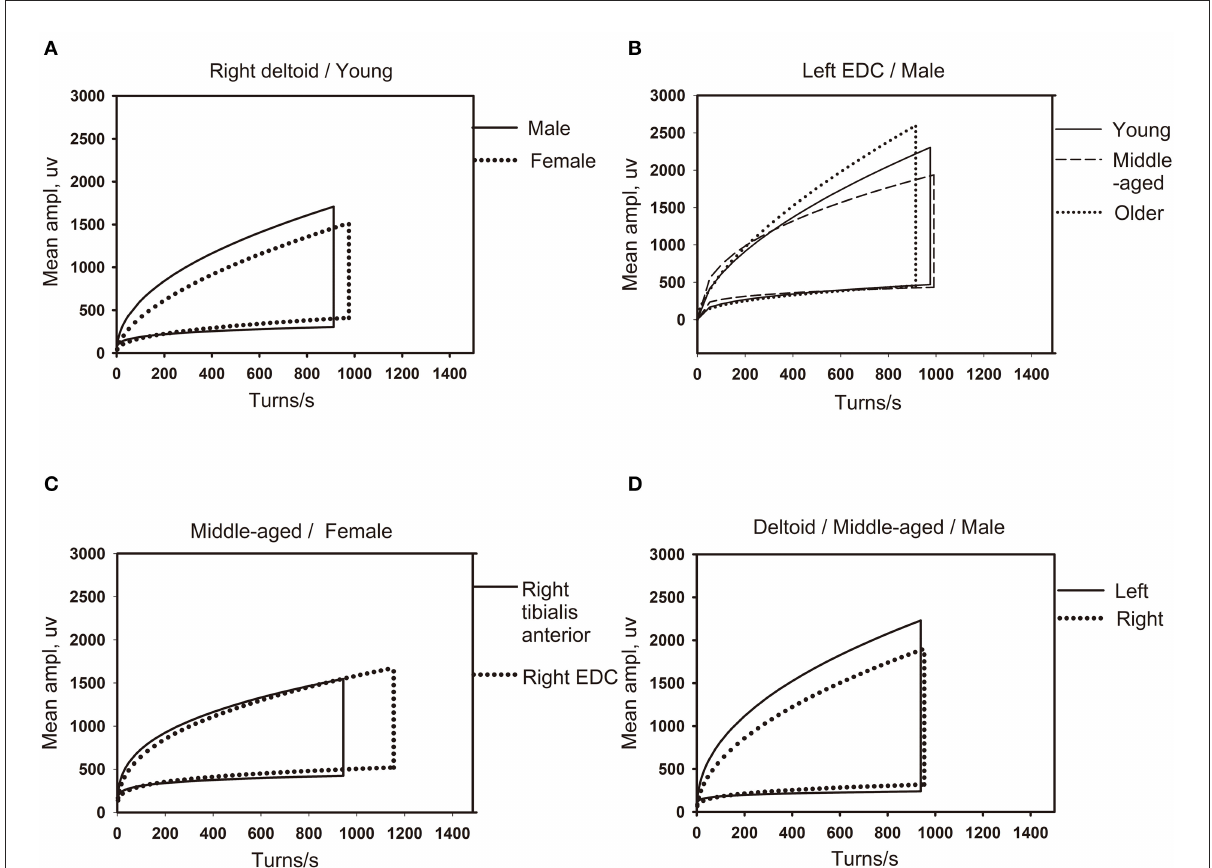
FIGURE3 The influence of different factors on the shape of the linear regression clouds. (A) The clouds of different gender for same muscle (right deltoid) in the youth group (18–44 years old). (B) The clouds of different age groups for the same gender (male) in the same muscle of left extensor digitorum communis (EDC). (C) The clouds of different muscles (right tibialis anterior and right EDC) for the same gender (female) in middle-aged group (45–49 years old). (D) The clouds of left and right limb muscles (left and right deltoid) for the same gender (male) in middle-aged group (45–49 years old). EDC, extensor digitorum